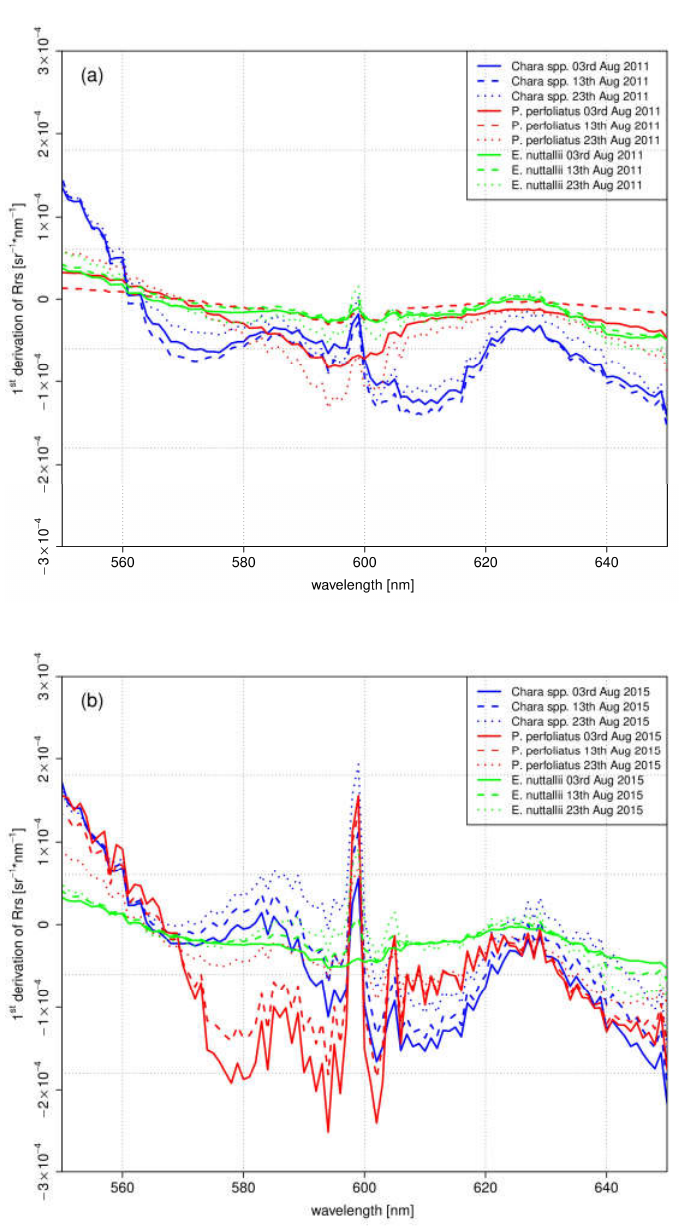
Figure 9. 1st Derivation of in-situ R rs spectra of: August 2011 ( a ); and August 2015 ( b ), in a wavelength range between 550 nm and 650 nm.